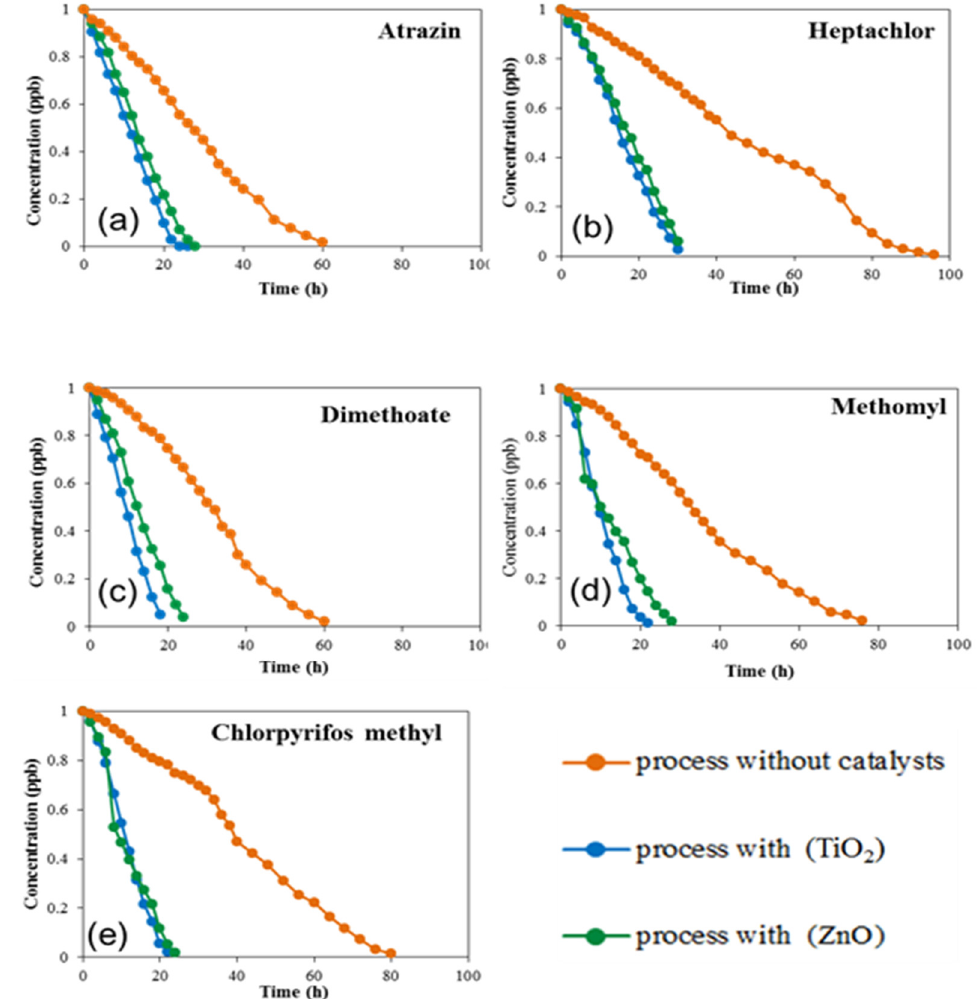
Figure 3. Variation of the concentration of the pesticides as a function of time under UV irradiation in absence of photocatalysts (orange), presence of TiO 2 (blue) and ZnO (green) for ( a ) atrazine, ( b ) heptachlor, ( c ) dimethoate, ( d ) methomyl, ( e ) chlorpyrifos methyl.